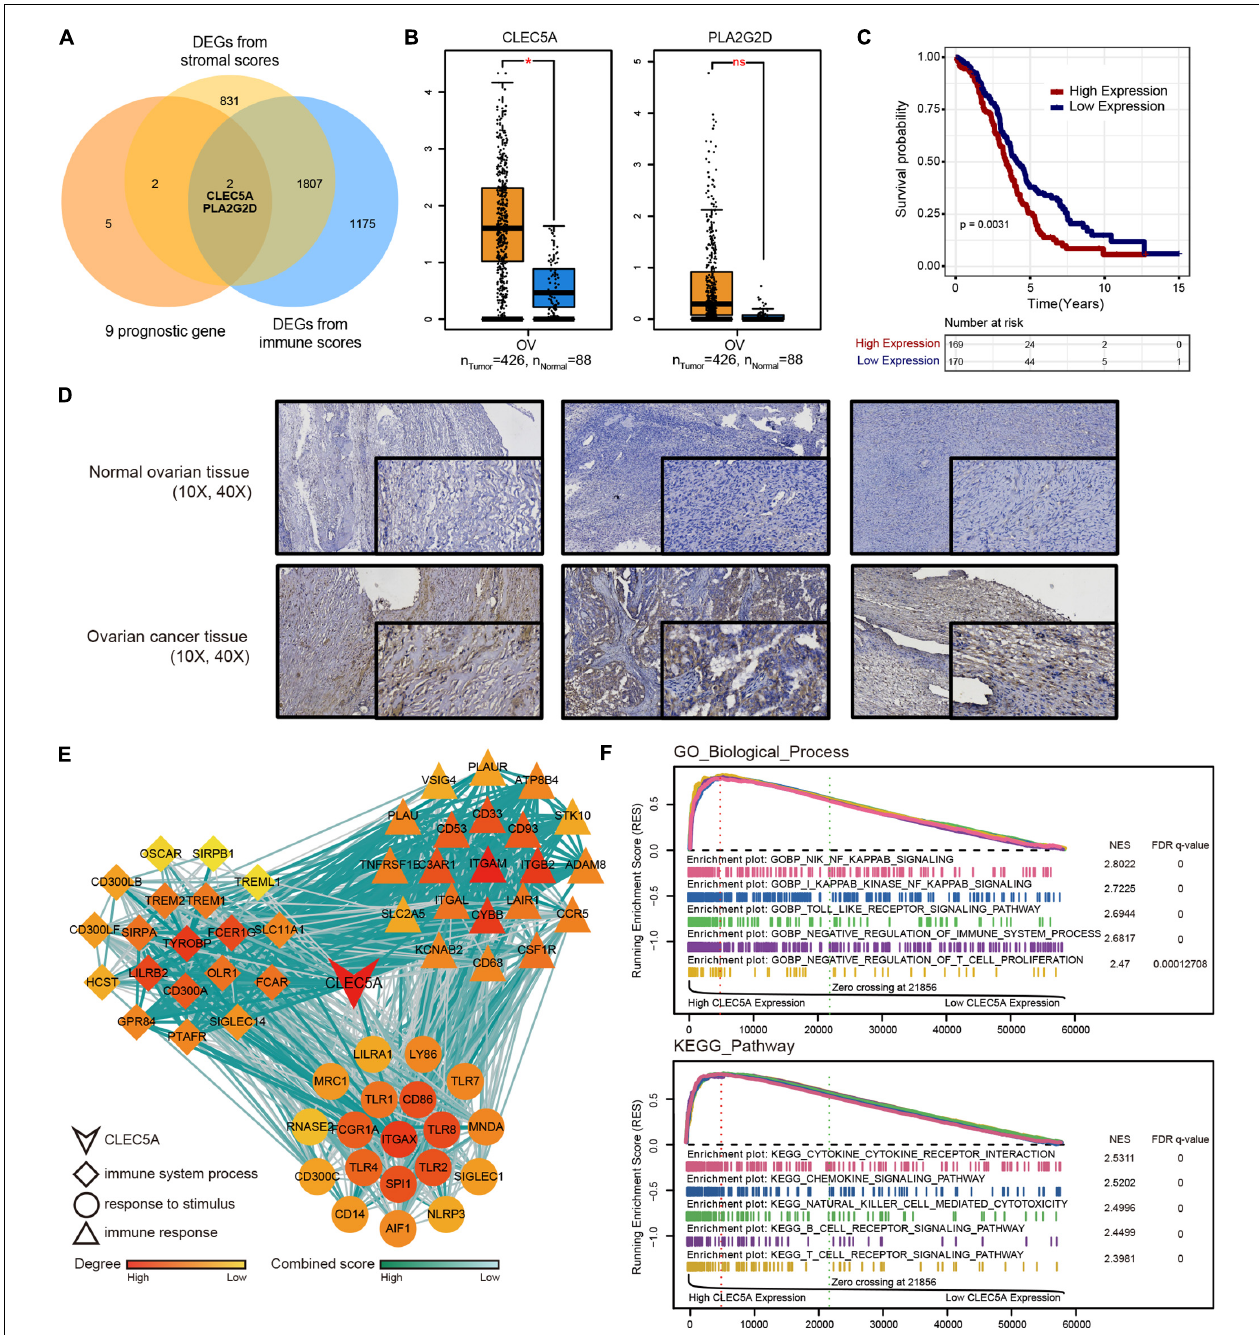
FIGURE 5 | (A) Venn diagram of DEGs from TMEscore and immune-stromal score. (B) Expression difference of CLEC5A and PLA2G2D in normal ovarian tissue and OC. (C) OS Kaplan–Meier curves of CLEC5A. (D) Expression of CLEC5A in normal ovarian tissue and OC (immunohistochemical staining). (E) The functions of three groups of CLEC5A-related genes. (F) Single-gene GSEA analysis of CLEC5A (GO-BP and KEGG pathway).*, p < 0.05; ns, no